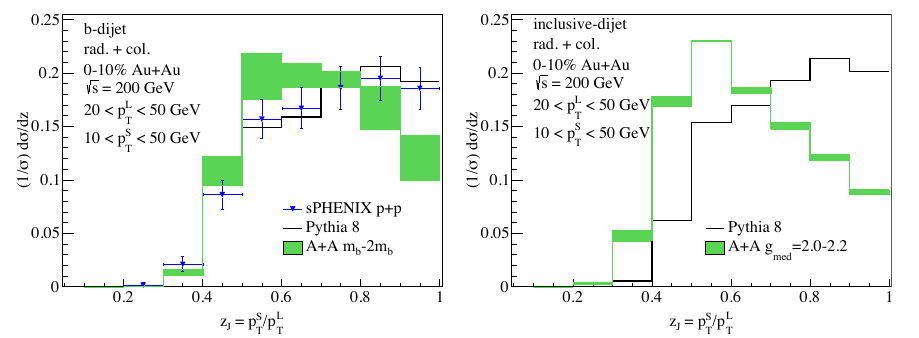
Figure 2. The dijet imbalance z J distributions for b-tagged (left) and inclusive (right) dijet production at √ s NN = 200 GeV with sPHENIX kinematics. The black histogram marks the distribution for p + p collisions, while the green marks that of Au + Au collisions. The blue “data” points come from preliminary simulations by the sPHENIX collaboration [10]. Left: the coupling of the jet to the medium is fixed at g med = 2 . 0 and the band corresponds to varying the range of masses of the propagating system between m b and 2 m b . Right: the band corresponds to varying the medium coupling g med = 2 . 0 2 . −